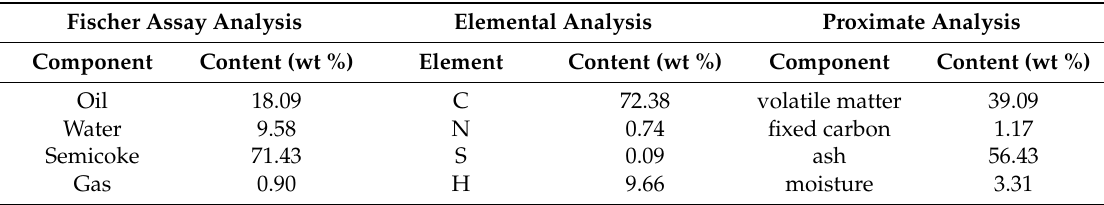
Table 1. Fundamental Characteristics of Huadian Oil Shale